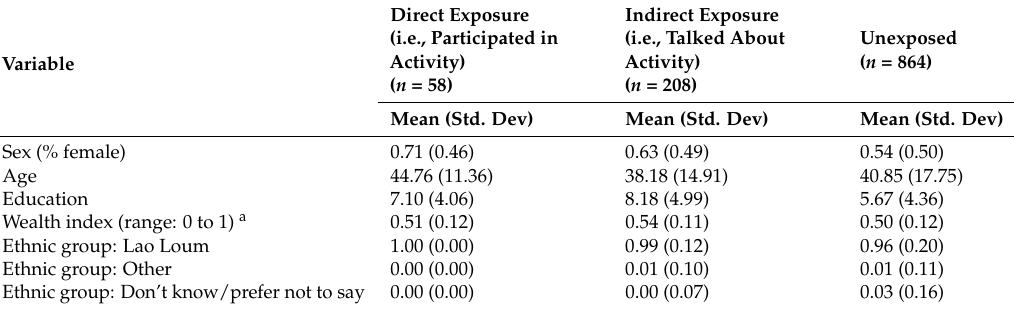
Table 5. Characteristics of individuals by activity exposure.